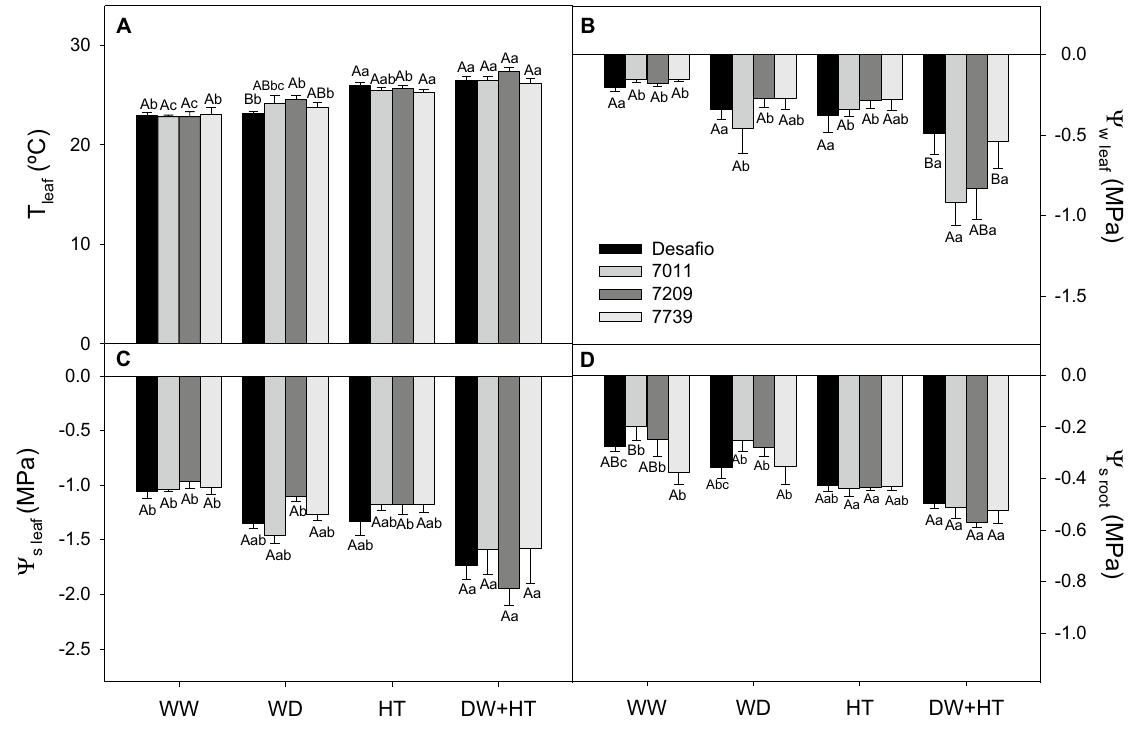
Figure 1. Leaf temperature and hydric status of soybean plants maintained for 8 days under well-watered (WW; 100% holding water capacity HWC, 25 °C), water deficit (WD; 40% HWC, 25 °C), high temperature (HT; 100% HWC, 40 °C), and water deficit plus high temperature (WD + HT; 40% HWC; 40 °C) conditions. ( A ) Leaf temperature (°C). ( B ) Leaf water potential ( Ѱ w(am) ). ( C ) Leaf osmotic potential ( Ѱ s(leaf) ). ( D ) Root osmotic potential (Ψ s(root) ). Bars represent mean ± SE ( n = 5). Means followed by the same uppercase letters compare cultivars within the same water and temperature treatment. Means followed by the same lowercase letters compare water and temperature treatments within the same cultivar, as determined by the Tukey test at 5% of